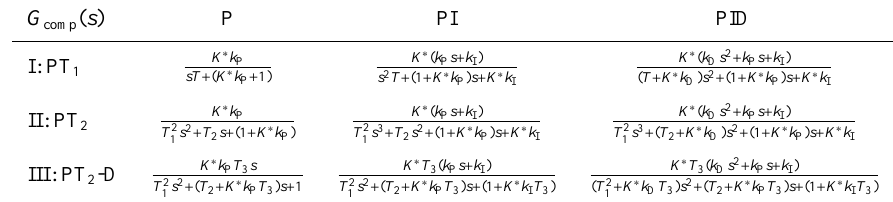
Table 4. Closed-loop transfer functions G comp ( s ) for all sensor-controller combinations considered; K ∗ = K · V